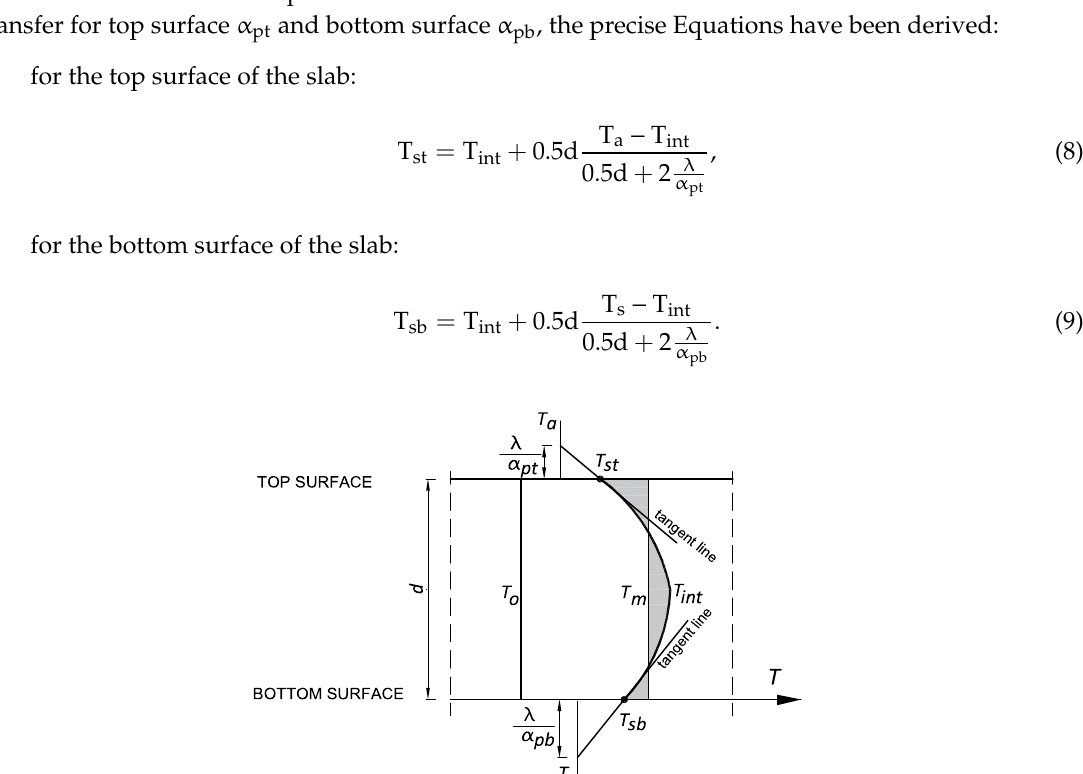
Table 4. Reduction coefficients a (cid:2914) . Cement Type